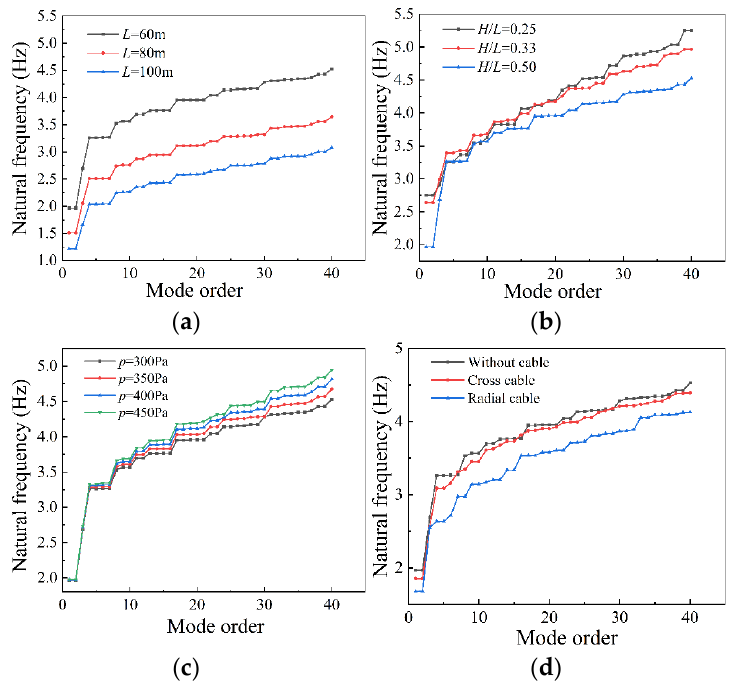
( f ) Figure 9. Modal shapes of spherical inflatable membrane structures: ( a ) 1st and 2nd horizontal modes (without cable); ( b ) 3rd vertical mode (without cable); ( c ) 1st and 2nd horizontal modes (cross cable); ( d ) 3rd vertical mode (cross cable); ( e ) 1st and 2nd horizontal modes (radial cable); ( f ) 3rd mode vertical (radial cable). The influence of span, rise–span ratio, internal pressure, and cable configuration on natural frequency is shown in Figure 10. It is observed that the natural frequency charac ‐ teristics of spherical inflatable membrane structures with different spans are similar. It is observed from Figure 10a that the natural frequencies of spherical inflatable membrane structures are decreased with the increment of the span. Therefore, with the increment of the span, the structure becomes more sensitive to wind load. As shown in Figure 10b, for